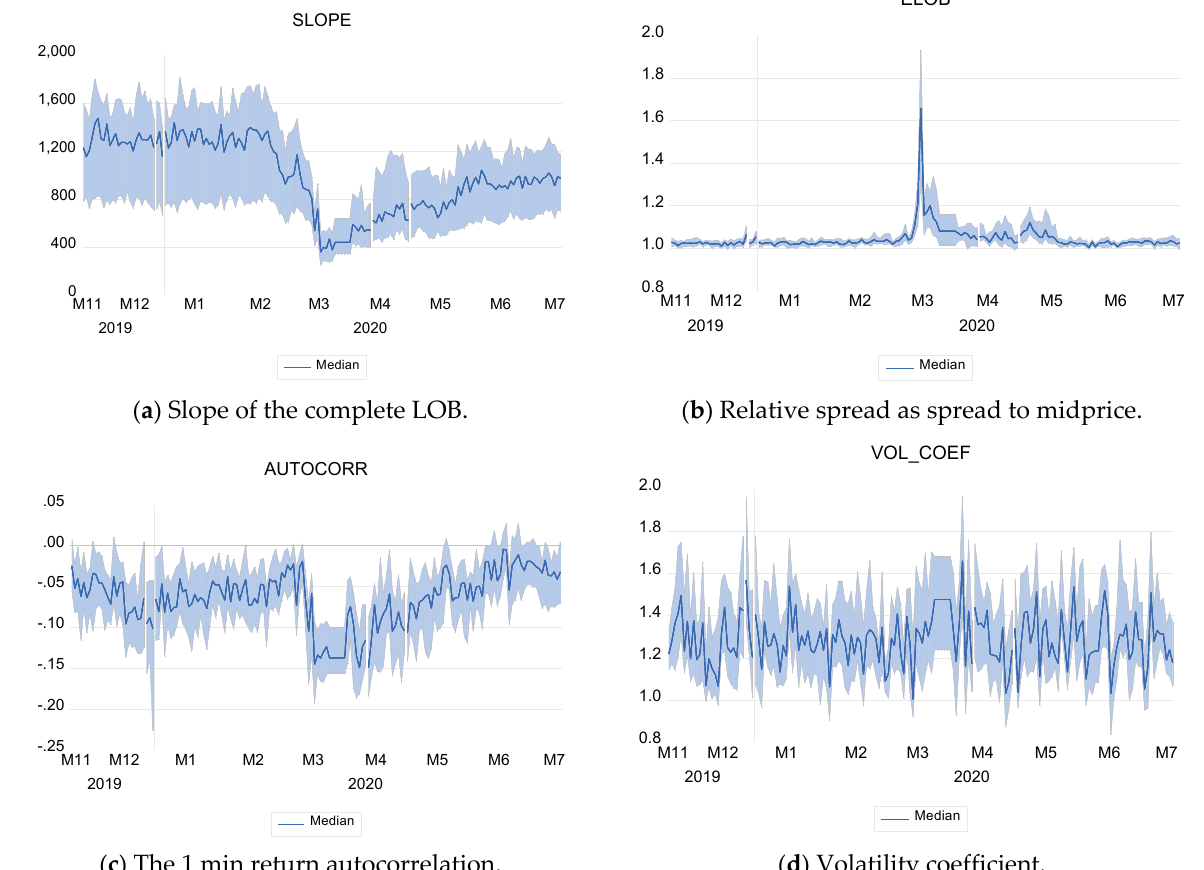
Figure 3. Efficiency measures during the periods under study. Median and 1st and 4th quartiles range are shown. ( a ) Slope on the complete snapshot LOB. ( b ) ELOB. Relation among buy and sell slopes of the complete LOB. ( c ) The 1 min first-order return autocorrelation. ( d ) Coefficient of scaled 1 min realized volatility divided by 30 min realized volatility.